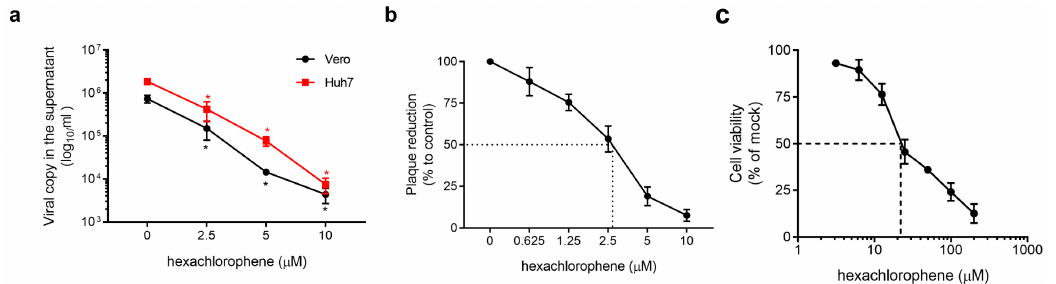
Figure 3. Evaluation of the in vitro anti-SFTSV activity of hexachlorophene. ( a ) SFTSV viral load reduction quantified by qRT-PCR in Vero and Huh 7 cells at 72 hpi (0.01 MOI) with hexachlorophene. ( b ) Half maximal inhibitory concentration (IC 50 ) of hexachlorophene is around 2.6 ± 0.14 µM as determined by plaque reduction assay in Vero cells. ( c ) Cell cytotoxicity assay of hexachlorophene in Vero cells as determined at 72 hpi. All experiments were performed in triplicates. * denotes p < 0.05 (compared to the DMSO control group by one-way ANOVA). Data are presented as mean values